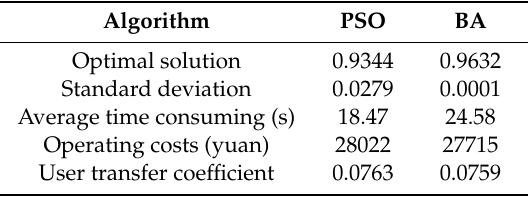
Table 4. Comparison of two algorithms.